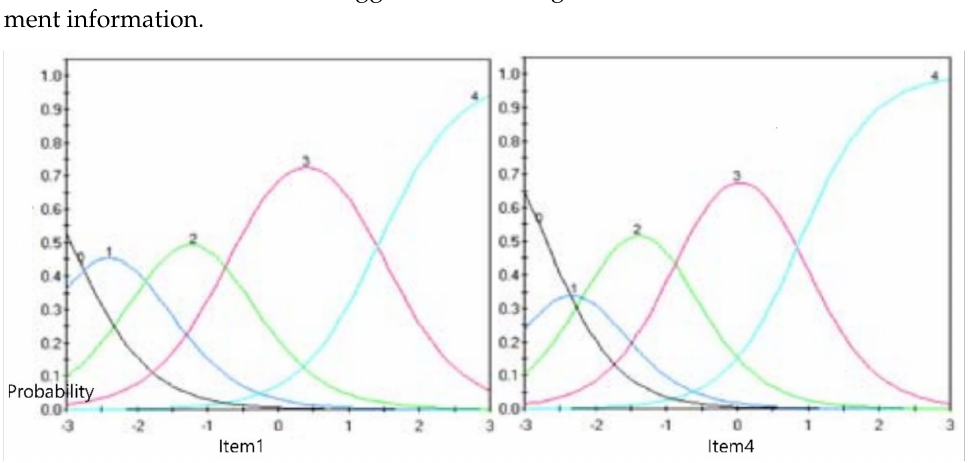
Figure 2. Exemplary probability response function curves (items 1 and